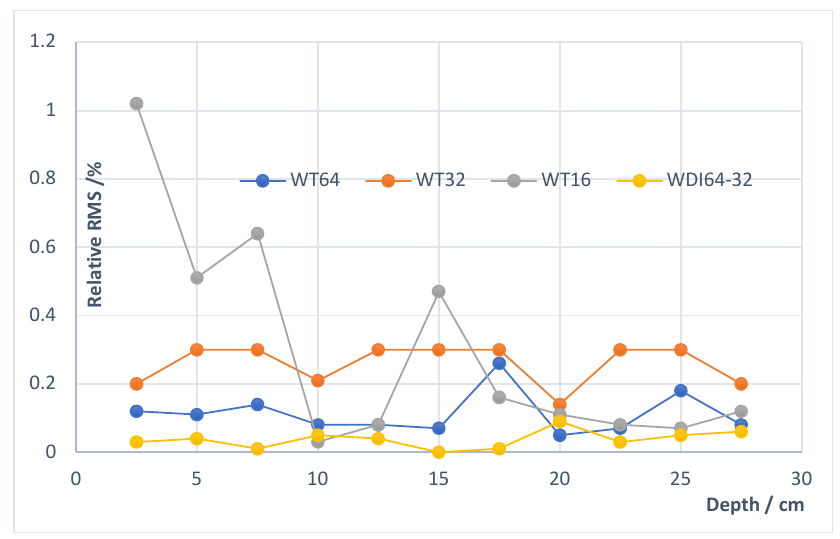
Figure 12. Comparison of RMS error point by point.